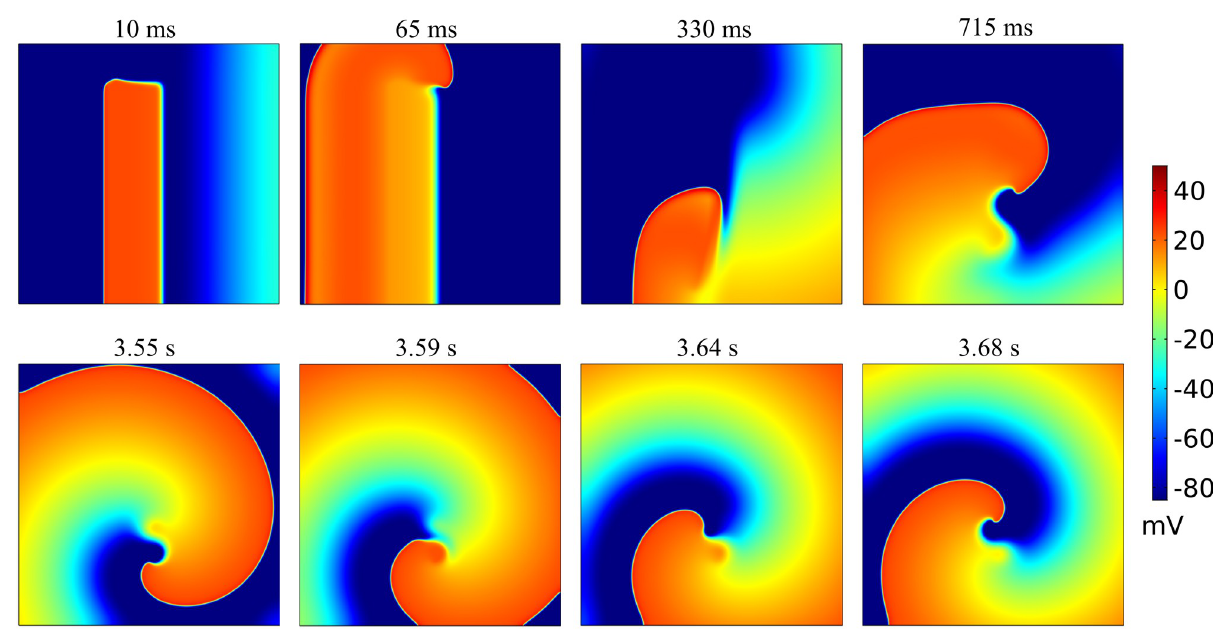
Fig 5. Reentrant spiral wave dynamics in 2D reproduced by our model. First row shows snapshots of the membrane potential during spiral wave initiation. Second row shows steady-state dynamics over an half period. Time instants above the pictures are relative to the delivery of S2 stimulus.